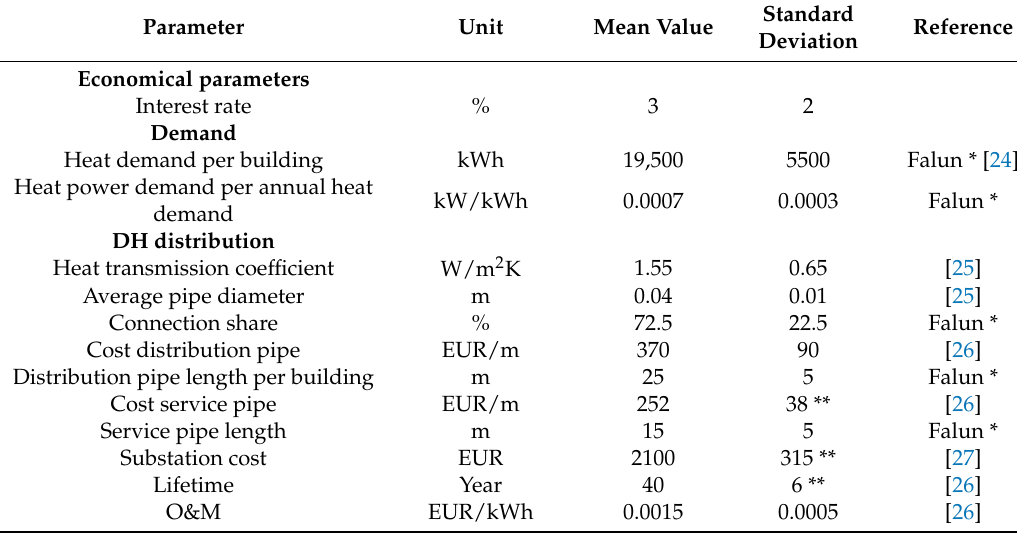
Table 1. Input parameters used and their mean value and standard deviation.